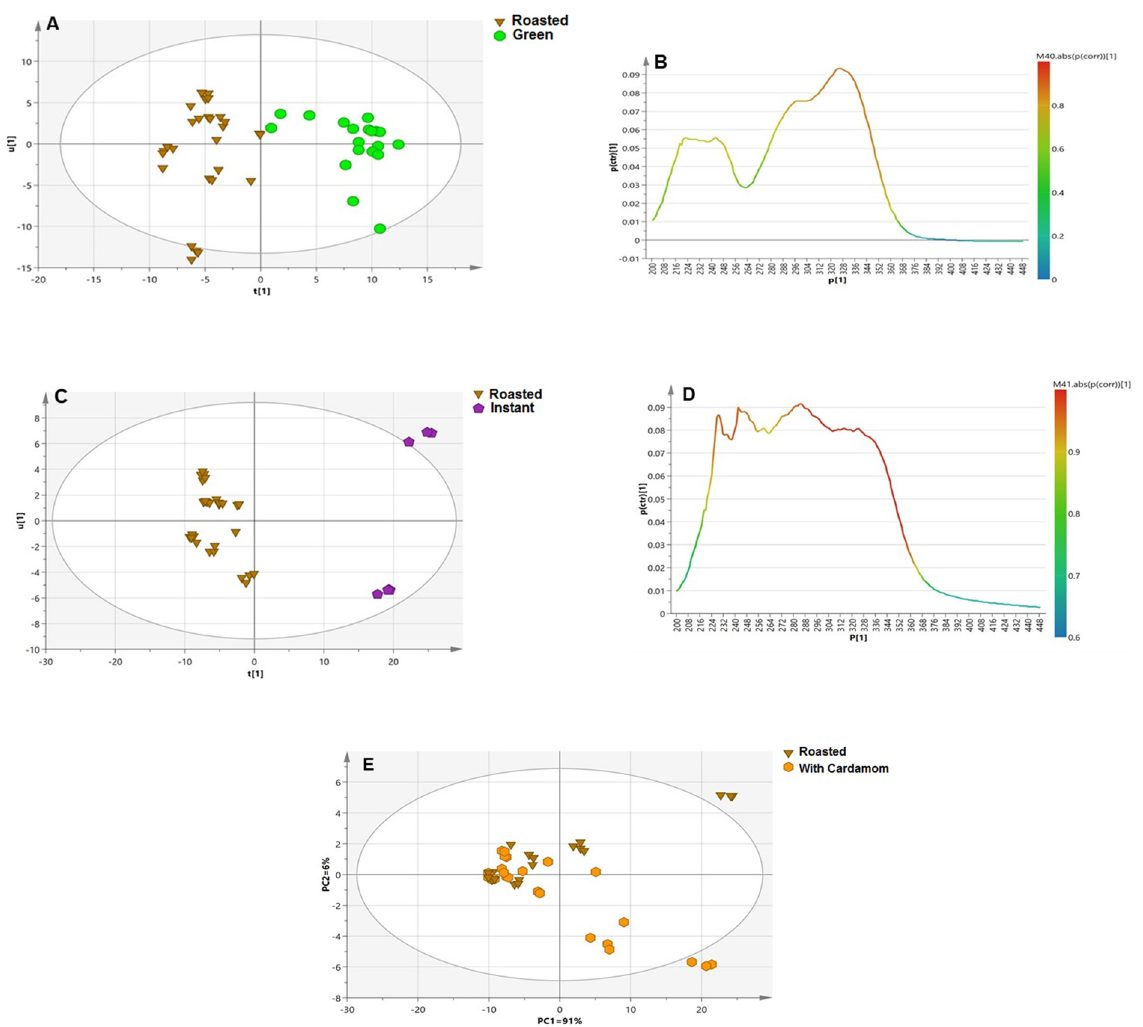
Figure 3. ( A ) OPLS-DA model for coffee samples (green versus roasted) based on UV–Vis analysis. ( B ) S-line based on roasting effect. ( C ) OPLS-DA for roasted versus instant samples. ( D ) S-line for instant and roasted samples. ( E ) PCA score plot model for plain roasted versus blended with cardamom samples. The S-plot shows the correlation (cor) and covariance p [1] between variables (wavelengths) and the predictive score of the discriminating component of OPLS-DA. The discriminant wavelengths in the important variables list are highlighted and discussed in the text.